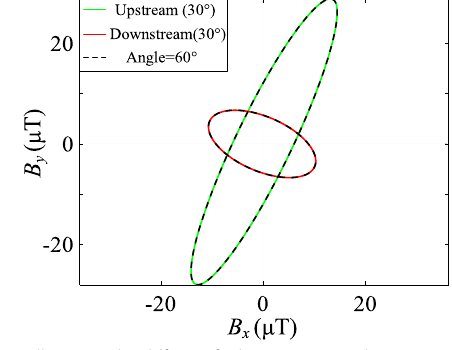
Fig. 19 Ellipses under different fault inception angles